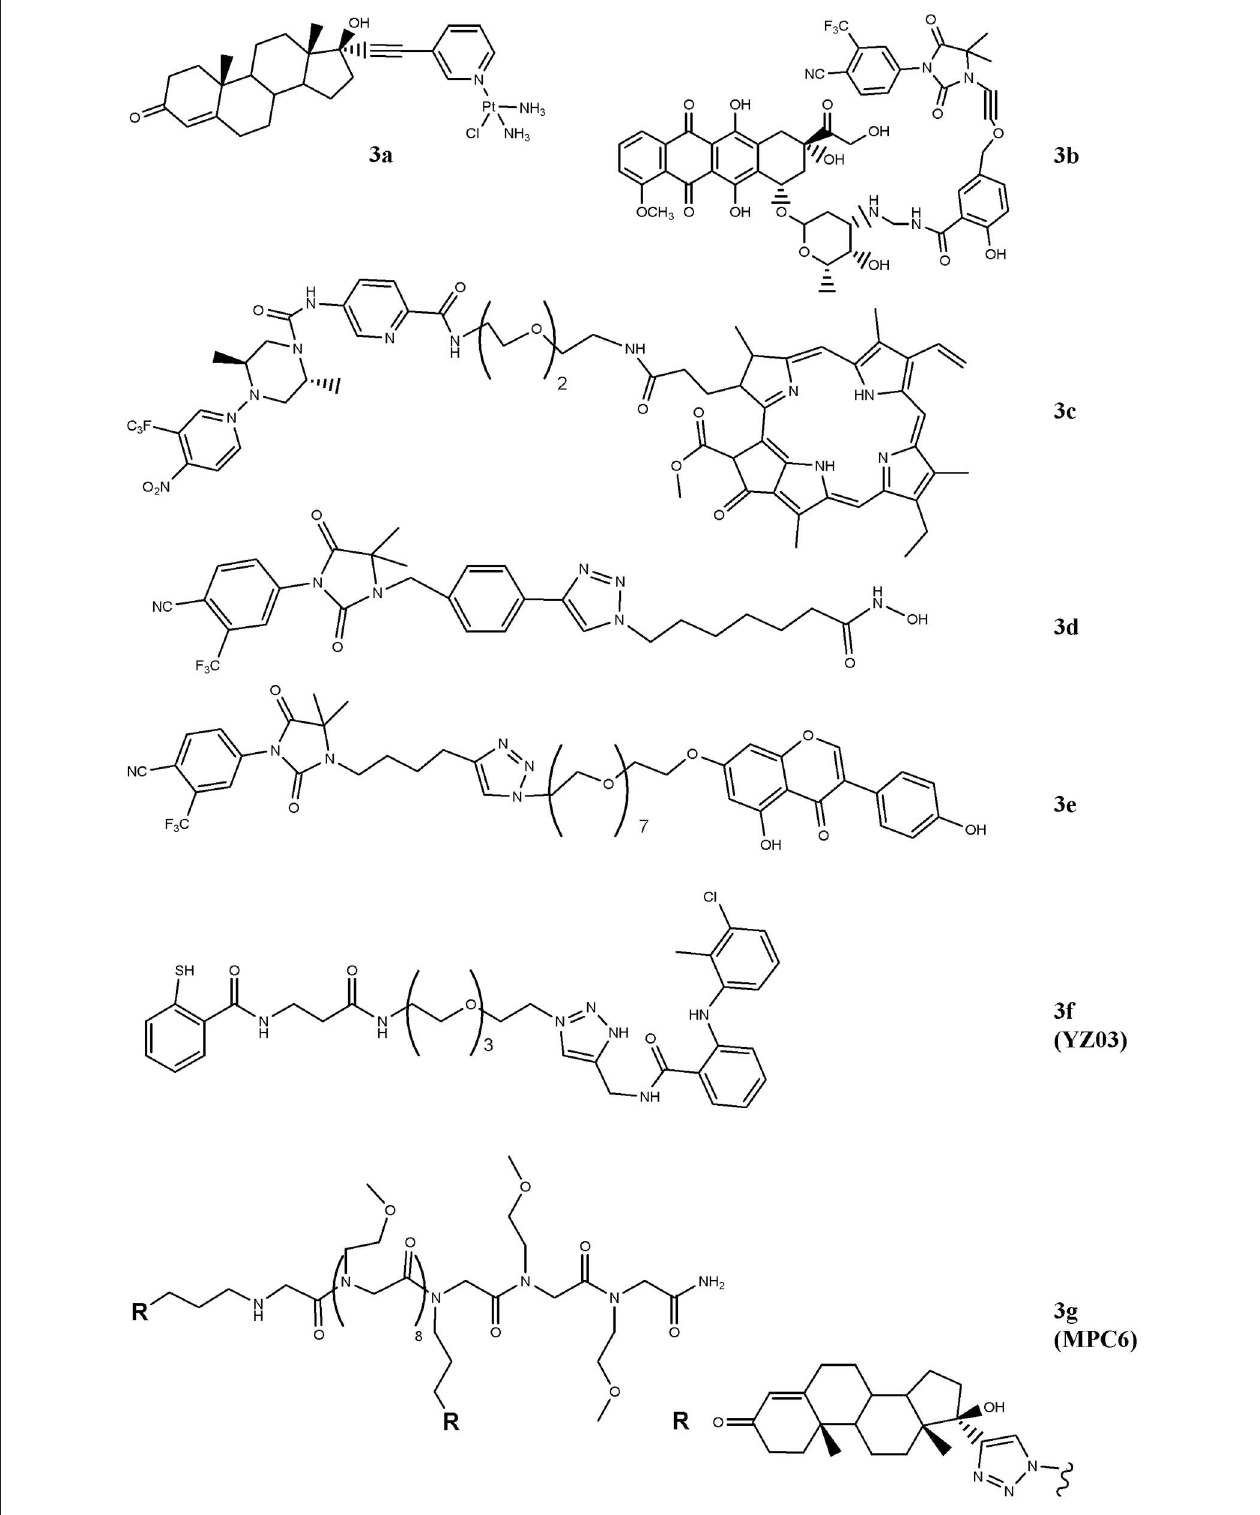
FIGURE 2 | Chemical structures of AR-ligand based conjugates for targeting small-molecules. The hybrid compounds containing conventional antitumor drugs (cisplatin, 3a ; doxorubicin, 3b ; and pheophorbide α , 3c ) are reported. The figure also shows the chemical structures of molecules that alter chromatin status ( 3d and 3e ) and that of compounds that interfere with AR/co-activators interactions ( 3f and 3g ).